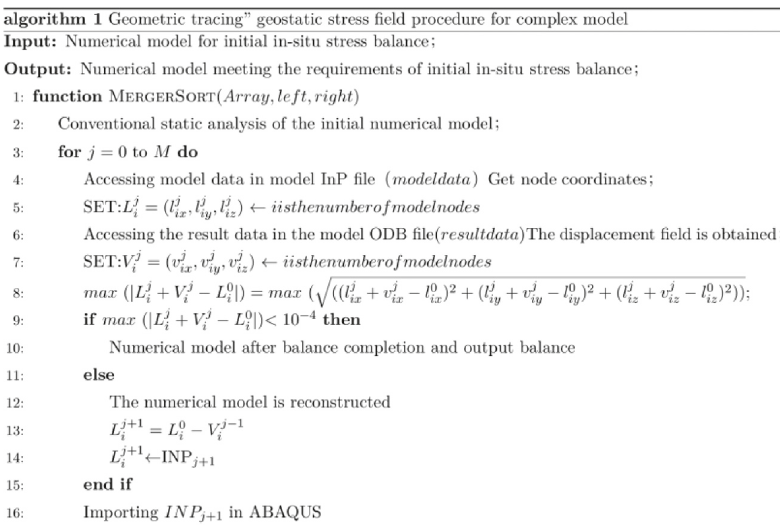
Figure 6: Pseudocode of the proposed method.